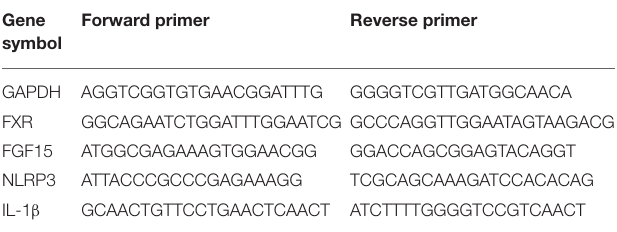
TABLE 1 | Primers used for the real-time